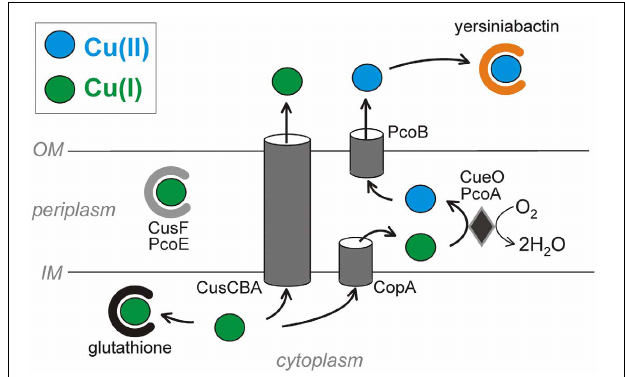
FIGURE 1 | Copper resistance strategies across pathogenic E. coli membranes. The virulence-associated siderophore yersiniabactin sequesters Cu 2 + outside the cell and prevents its reduction to the more toxic Cu + . Copper ions that reach the cytosol are subject to chelation by glutathione and export by two ATPases. The CusCBA ATPase complex exports Cu + from both the cytoplasm and the periplasm ( via CusF) to the extracellular space. Alternatively, the CopA ATPase exports cytoplasmic copper across the inner membrane. Periplasmic Cu + can bind the proteins CusF and PcoE or be oxidized by the mixed copper oxidases CueO or PcoA to less toxic Cu 2 + . PcoB has a putative function of exporting Cu 2 + across the outer membrane. The systems are oriented to minimize free cytosolic copper ions by directing these to the periplasmic or extracellular